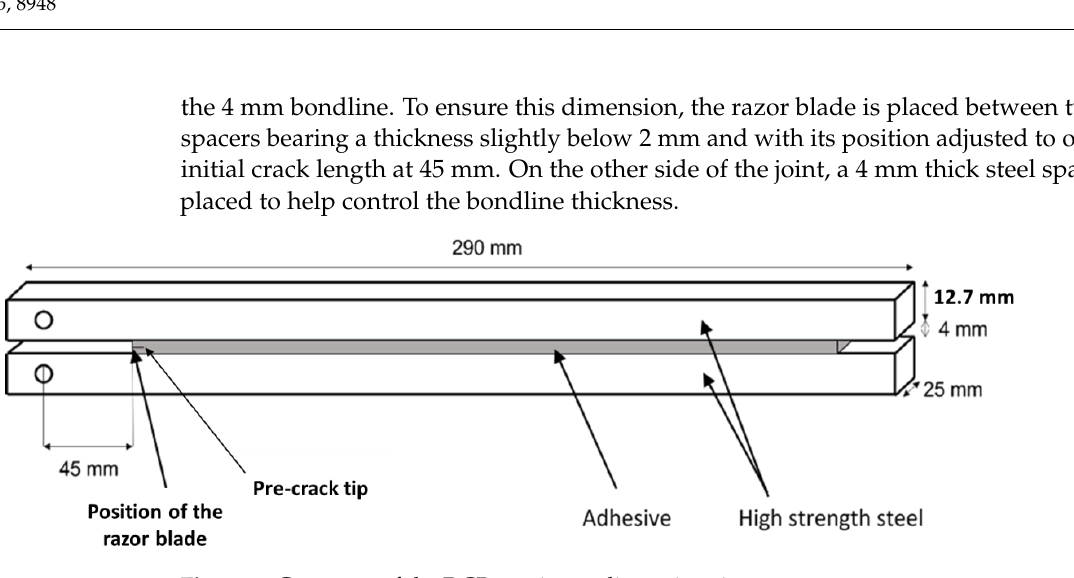
Figure 1. Geometry of the DCB specimen, dimensions in mm.